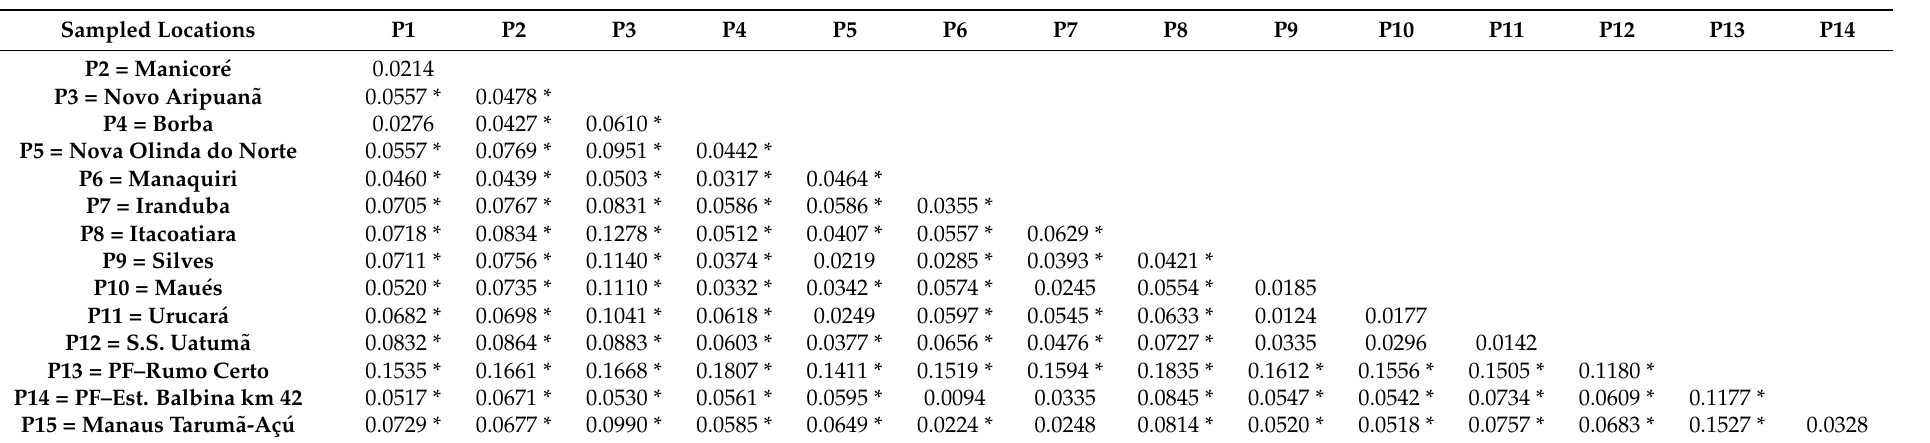
Table 3. Pairwise comparisons of F ST among 15 populations (P) of A. aculeatum collected in the state of